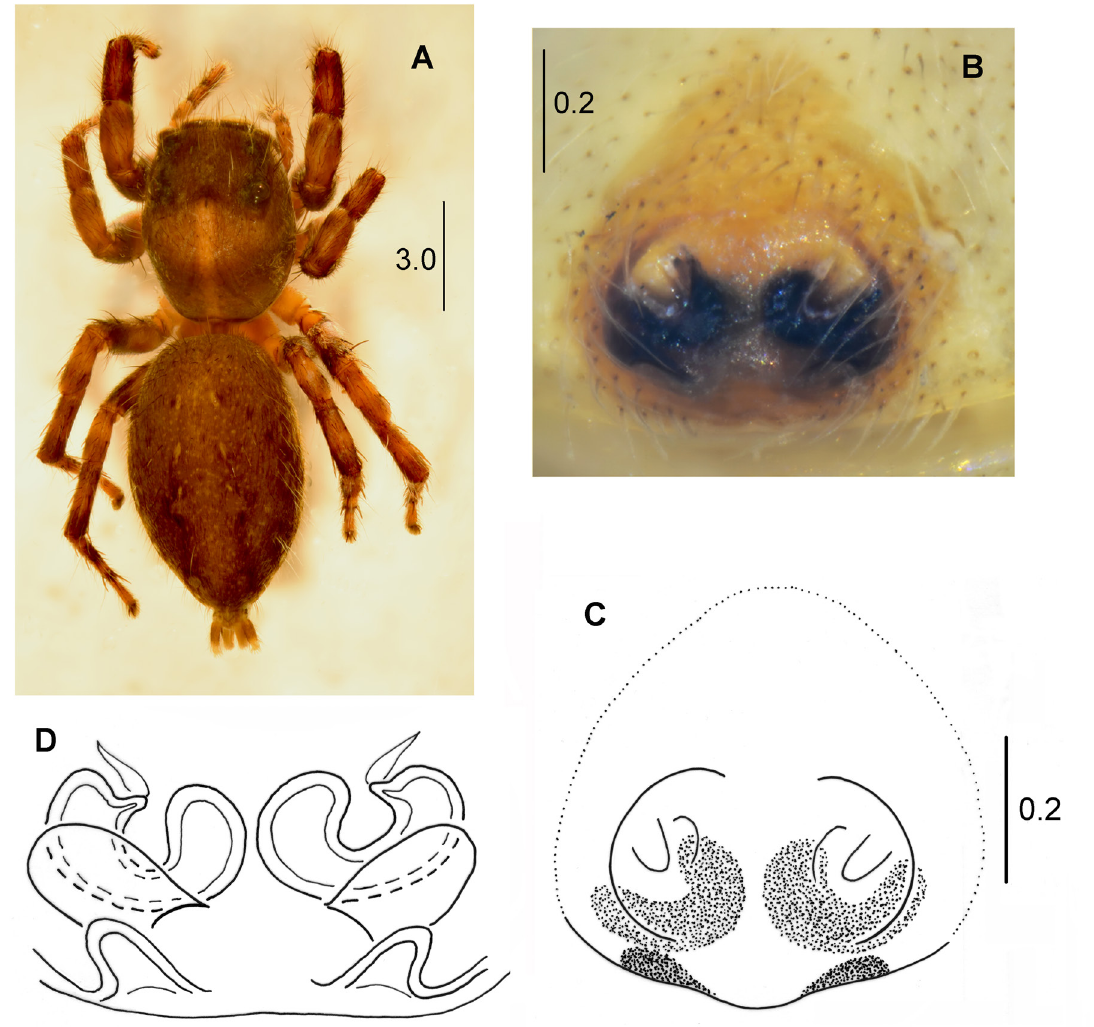
Fig. 26. Hyllus unicolor sp. nov., paratype, ♀ (MNHN). A . Habitus, dorsal view. B–C . Epigyne. D . Internal structure of